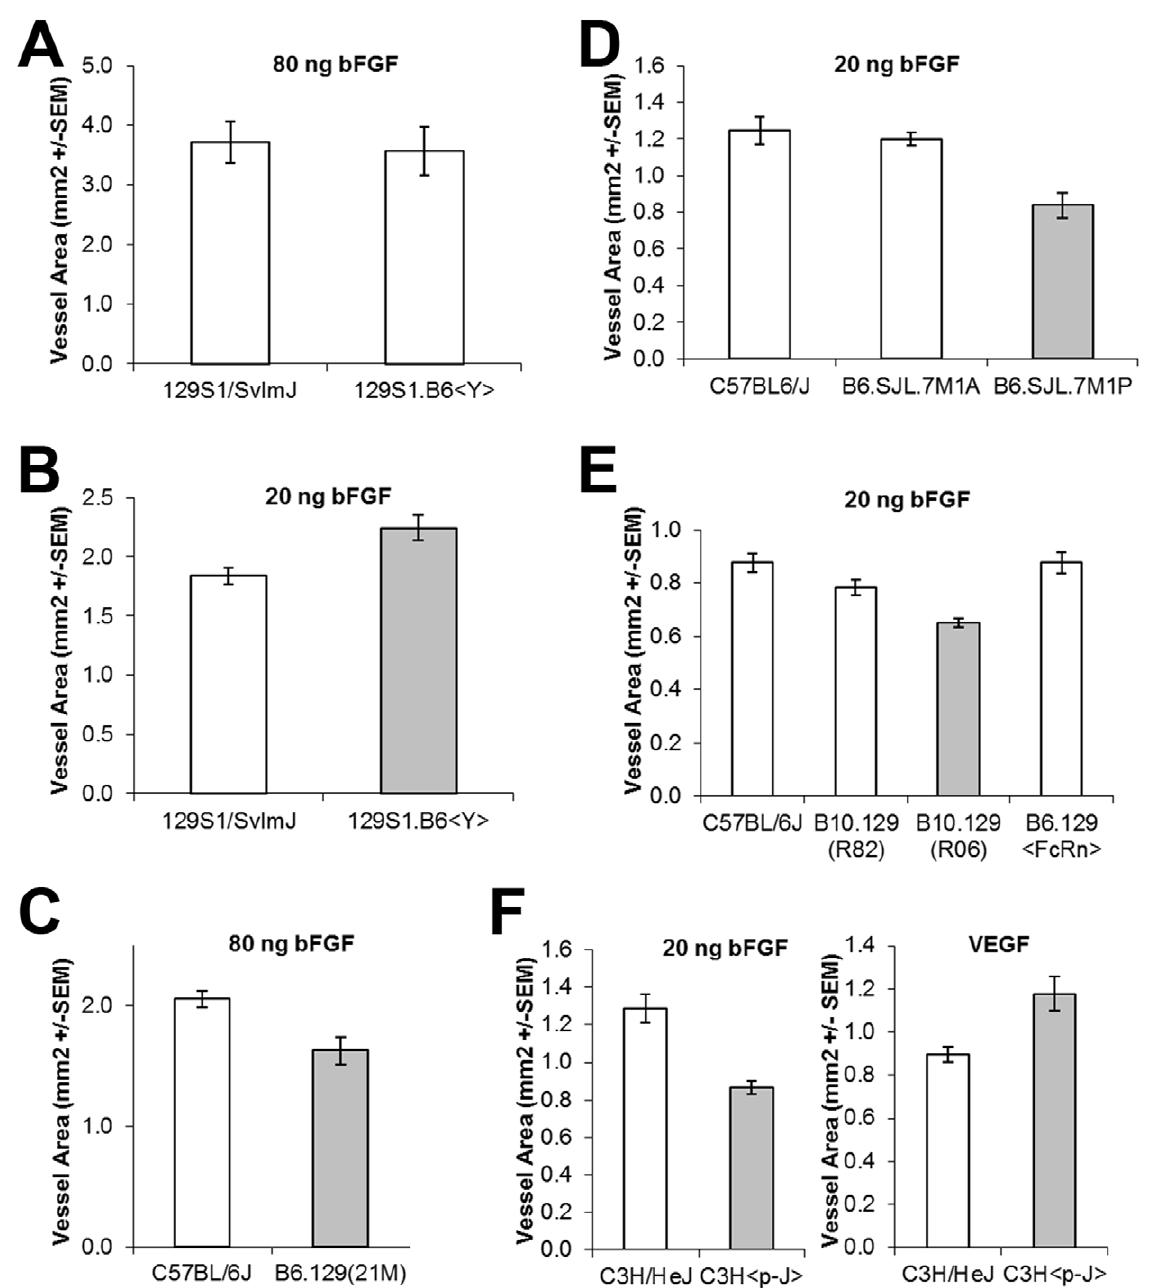
Figure 3. Angiogenic response of Congenic Strains. Differences between parental (leftmost) and congenic strains are statistically significant (P , 0.05) except when the bar for the congenic strain is colored white.